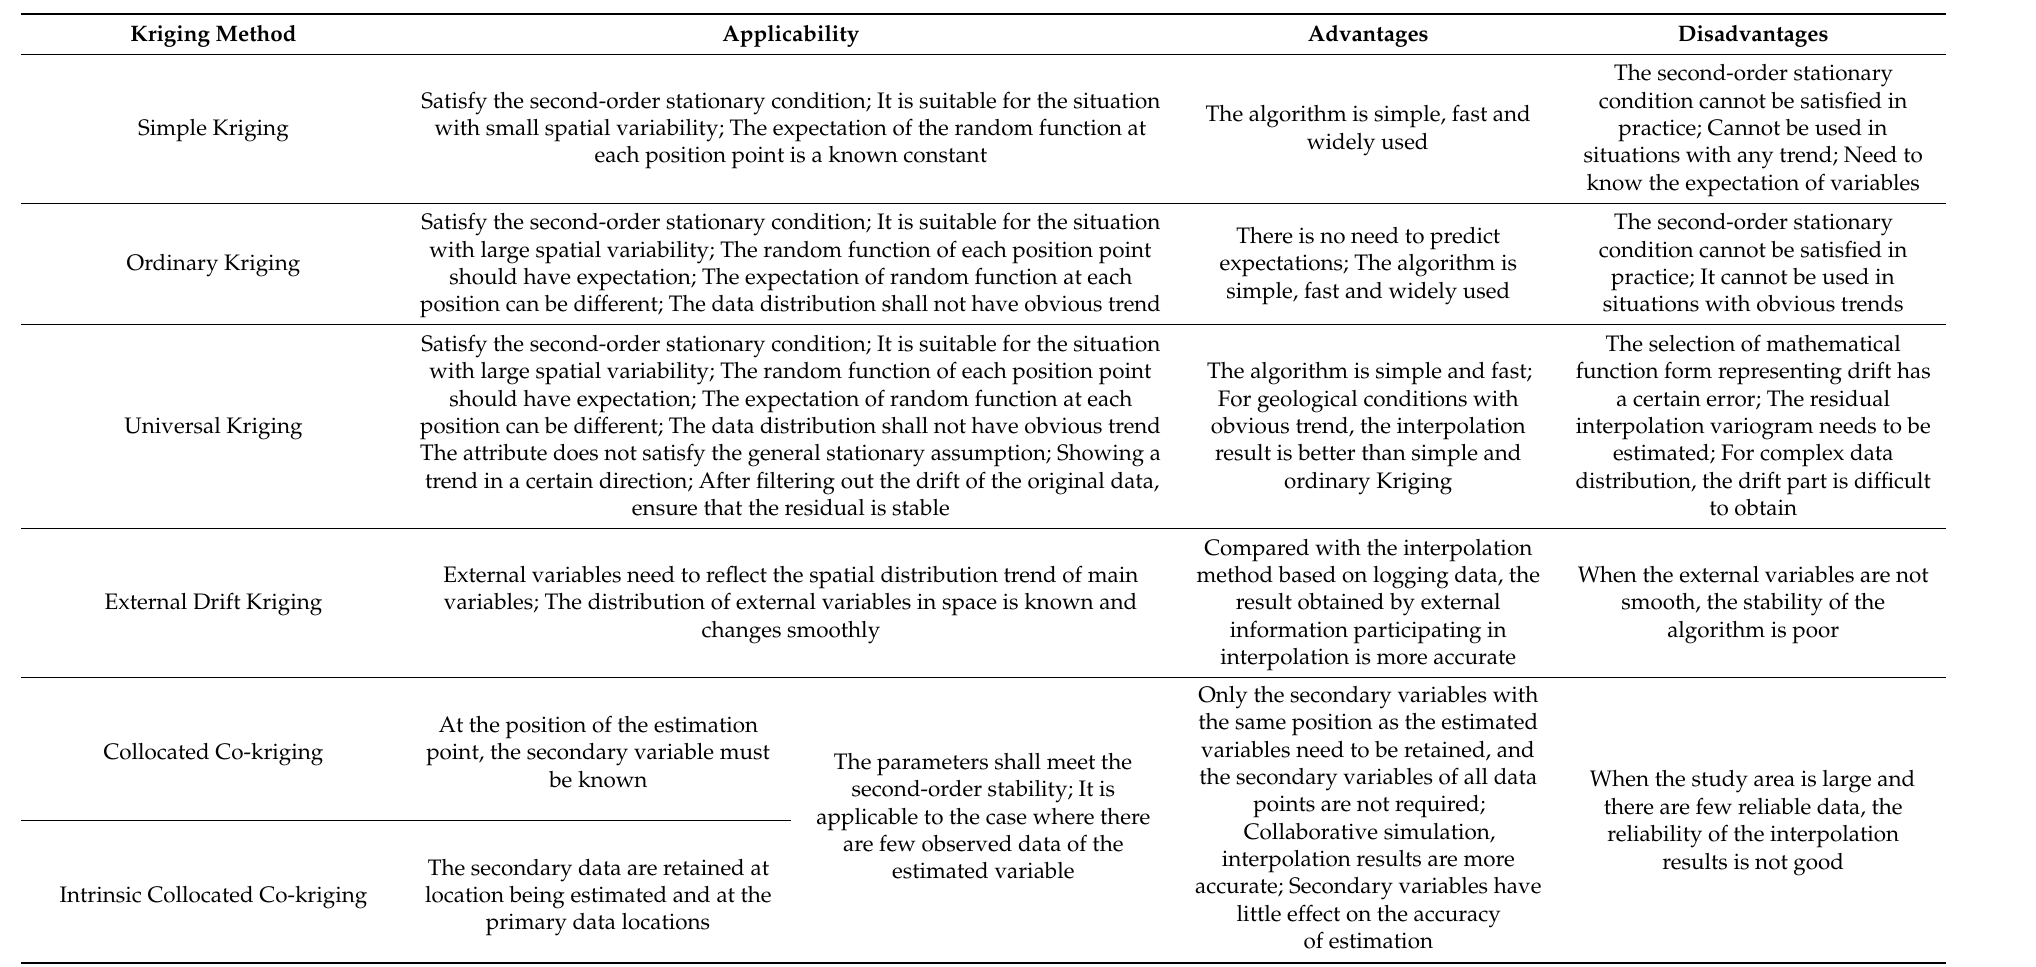
Table 1. Comparison of different Kriging